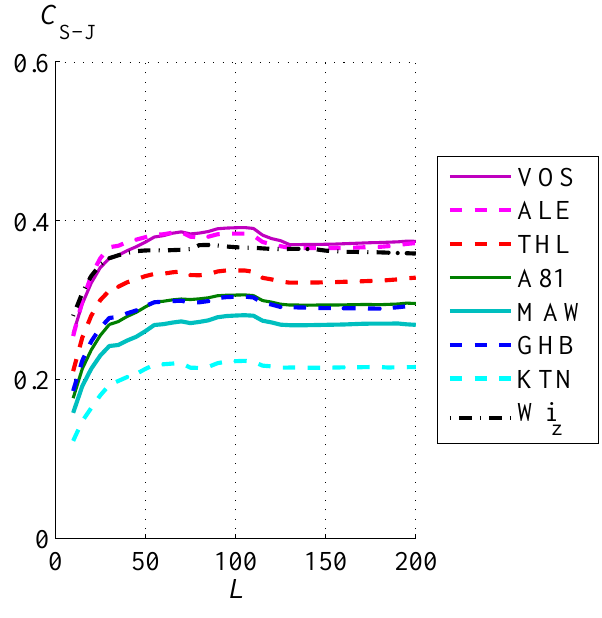
Fig. 6. Two years averaged correlation coefficient between S and WIND ion (8–30keV) flux J for 6 high latitude stations in depen- dence on sample length L . Black dash-dot line shows the correla- tion with S Bz